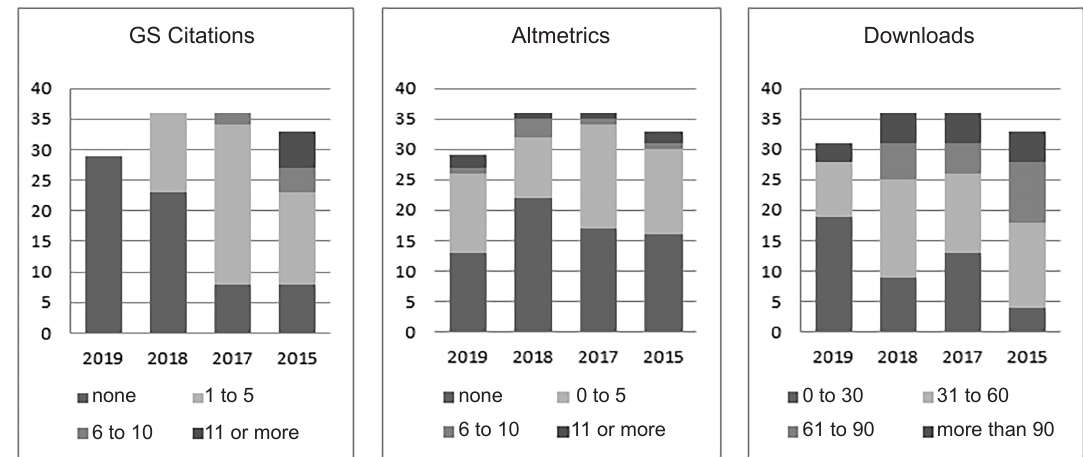
Figure 1. Distribution of performance by year of all Western Journal of Emergency Medicine Special Issues in Educational Research and Practice articles published based on Google Scholar citations, Altmetrics, and downloads. GS , Google